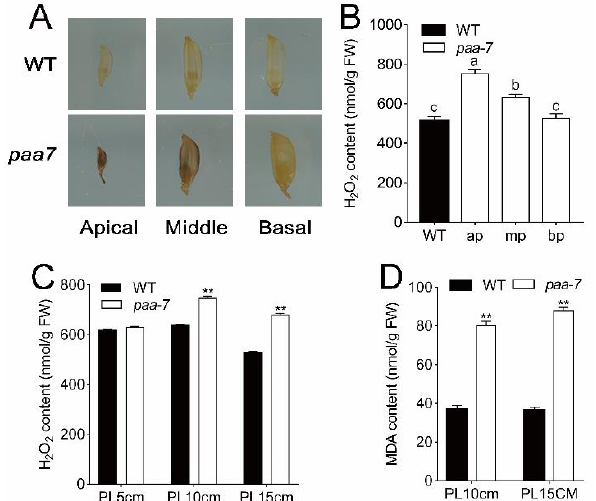
Figure 3. Determination of ROS content in WT and paa7 . ( A ) DAB staining of spikelets in different parts of rice panicle. ( B ) H 2 O 2 content in spikelets of apical part of the panicle in WT, apical part (ap), middle part (mp), and bottom part (bp) of panicle in paa7 ; data are means ± SD ( n =3); different letters indicate significant differences by one-way ANOVA and Duncan’s test ( p < 0.05). ( C ) H 2 O 2 content in apical spikelets at different stages of panicle development. ( D ) MDA content in apical spikelets at different stages of panicle development. Data are means ± SD ( n =3); asterisks indicate significant differences by Student’s t -test (** p < 0.01).